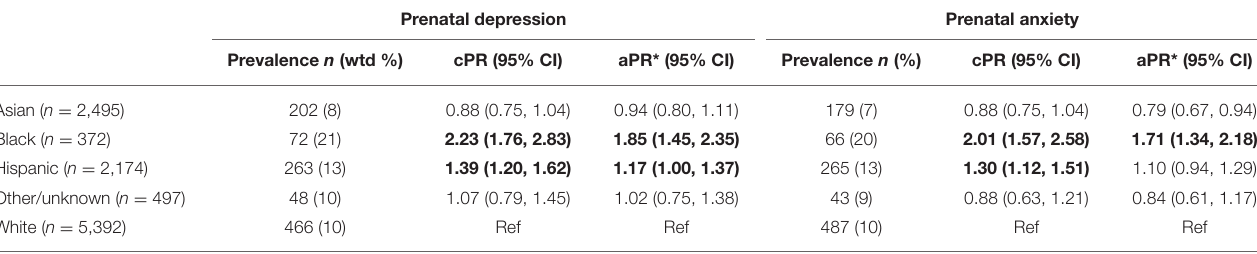
* Adjusted for age (continuous), month of survey (continuous), trimester of survey, parity, insurance. The bold values indicate statistically significant relationship.